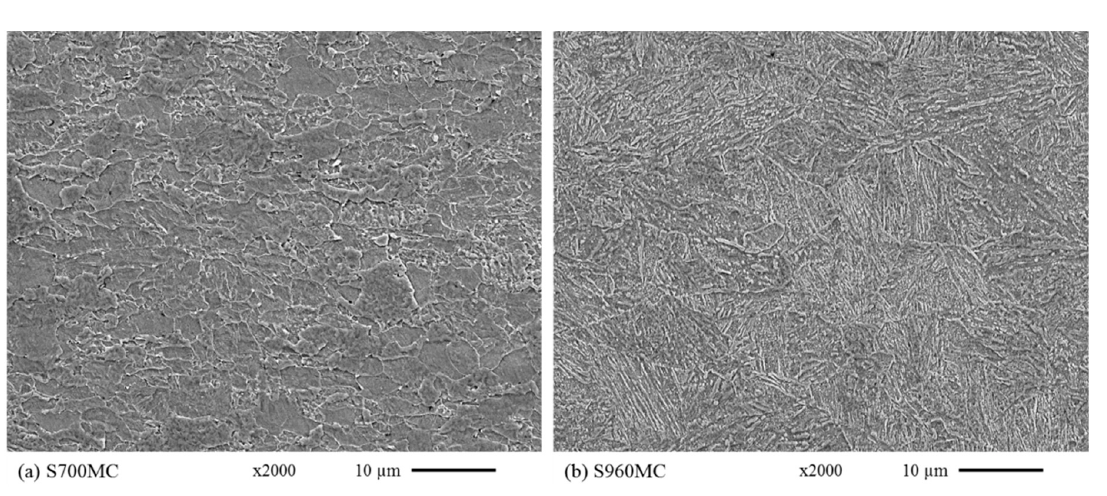
Figure 3. Microstructure micrograph for ( a ) 700MC and ( b ) S960MC.